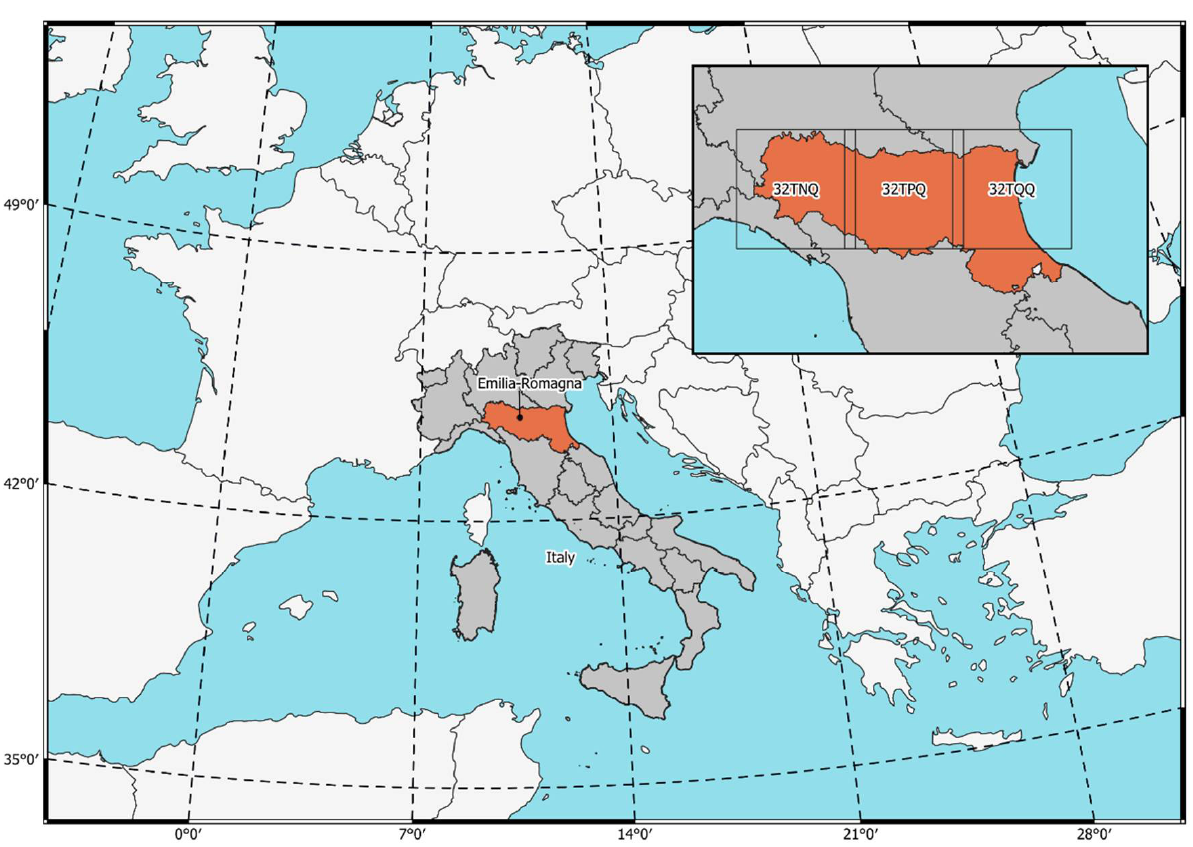
Figure 1. The study area was in the Emilia-Romagna region in the North of Italy (orange area, covered by Sentinel-2 tiles 32TNQ, 32TPQ, and 32TQQ).